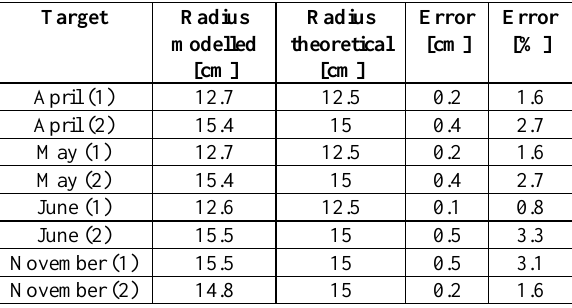
Table 5. 3D spherical target